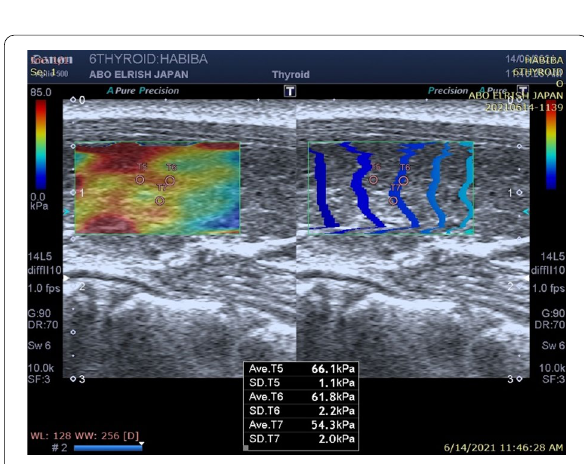
Fig. 4 SWE of right thyroid lobe showing three measurements of elasticity 66.1, 61.8 and 54.3